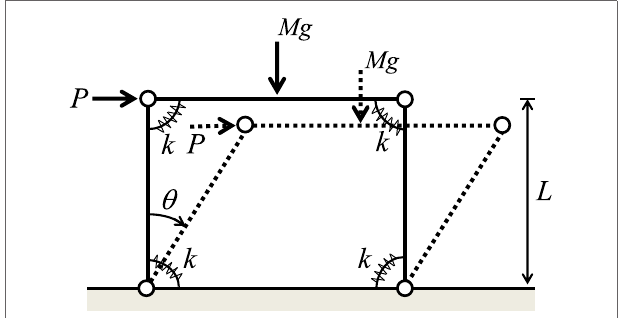
FIGURE A1 | One-story, one-span steel frame of three rigid bars connected by four rotational springs .